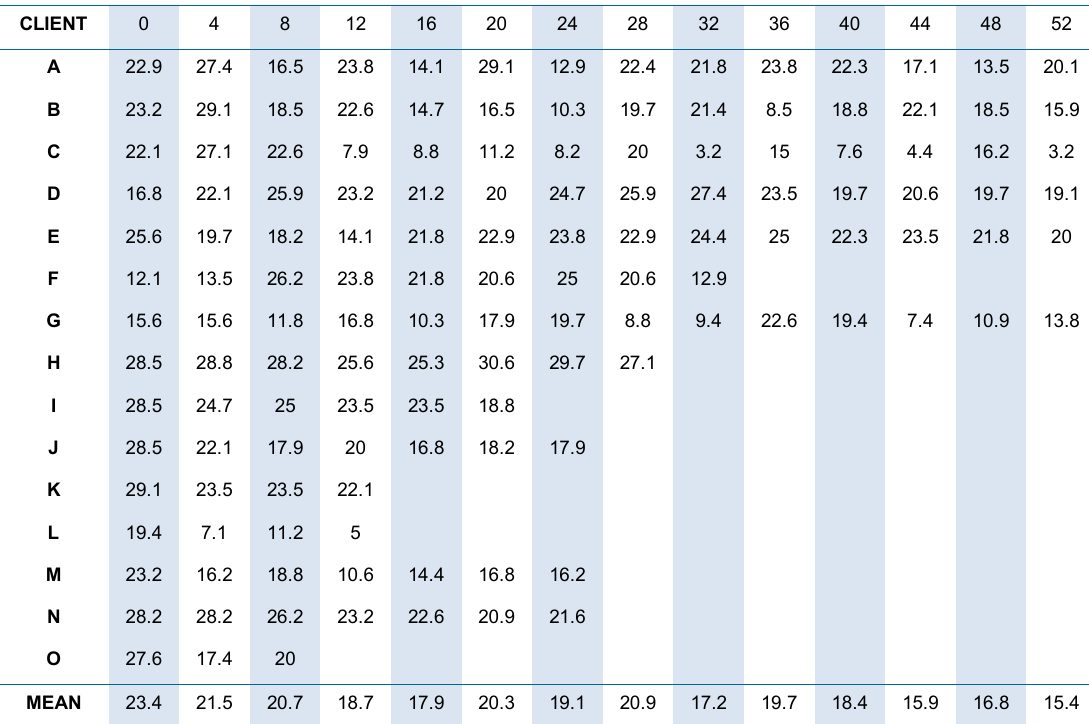
Table 10: Mean Clinical Core-OM score: all clients